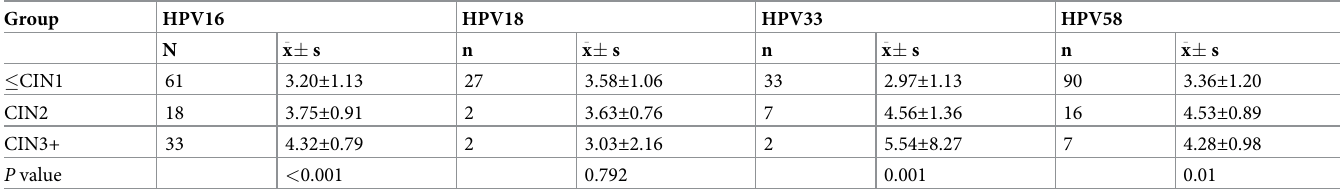
Table 2. Viral load � of individual HPV genotypes relative to the grade of cervical lesion (mean ± standard deviation). Group